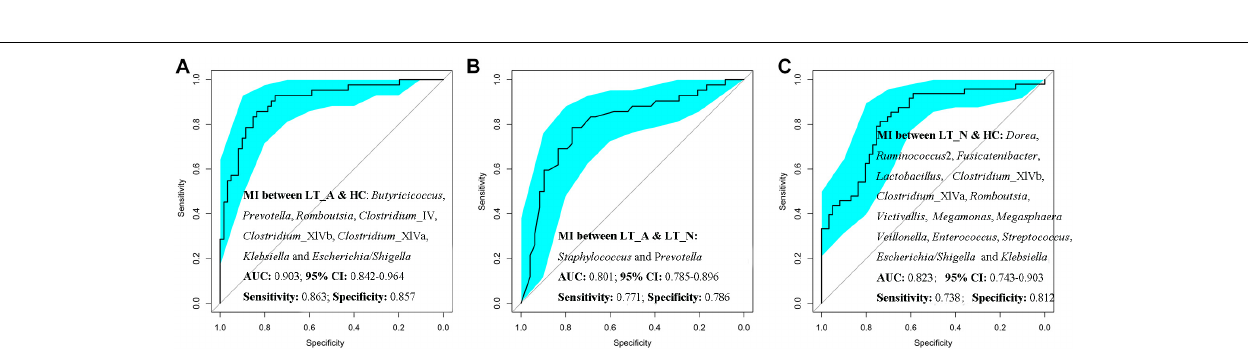
FIGURE 6 | Prediction of the key genera (microbiotal index, MI) in the fecal microbiomes of LT_A, LT_N, and HC. (A) ROC curves for Prevotella , Romboutsia , Klebsiella , Escherichia_Shigella , Butyricicoccus , Clostridium _IV, Clostridium _XIVb, and Clostridium _XIVa could be used to distinguish samples belonging to Group LT_A from those of Group HC, with ROC plot AUC values of 0.903 and sensitivity and specificity values of 0.812 and 0.690, respectively. (B) ROC plots for Staphylococcus and Prevotella could distinguish fecal microbiomes of Group LT_A recipients from those of Group LT_N, with ROC-AUC values of 0.801 and sensitivity and specificity values of 0.771 and 0.786, respectively. (C) ROC plots for Victivallis , Romboutsia , Megasphaera , Megamonas , Veillonella , Lactobacillus , Klebsiella , Escherichia/Shigella , Enterococcus , Streptococcus , Ruminococcus 2, Fusicatenibacter , Dorea , Clostridium_ XIVb, and Clostridium XIVa could distinguish fecal microbiomes from Group LT_N recipients from those of Group HC, with ROC-AUC values of 0.823 and sensitivity and specificity values of 0.738 and 0.812, respectively. LT_A, fecal microbiomes of the liver recipients with abnormal liver function; LT_N, fecal microbiomes of the liver recipients with normal liver function; HC, fecal microbiomes of the healthy control group; ROC, receiver operating characteristic; AUC, the area under the parasitemia curve.